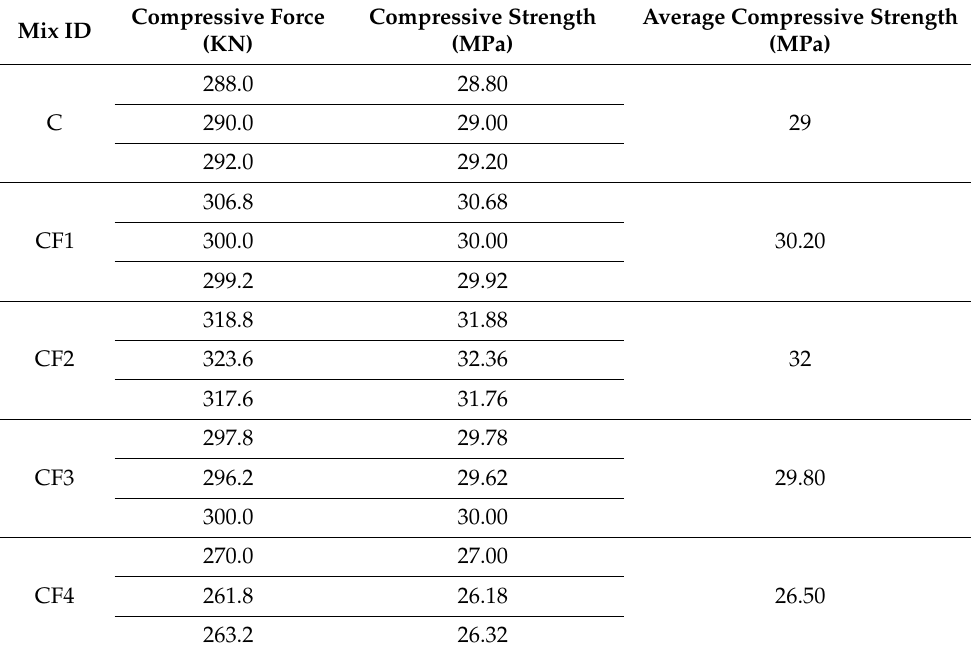
Figure 4. Development of compressive strength of coir fiber-modified concrete. Table 5. Compressive strength of concrete.